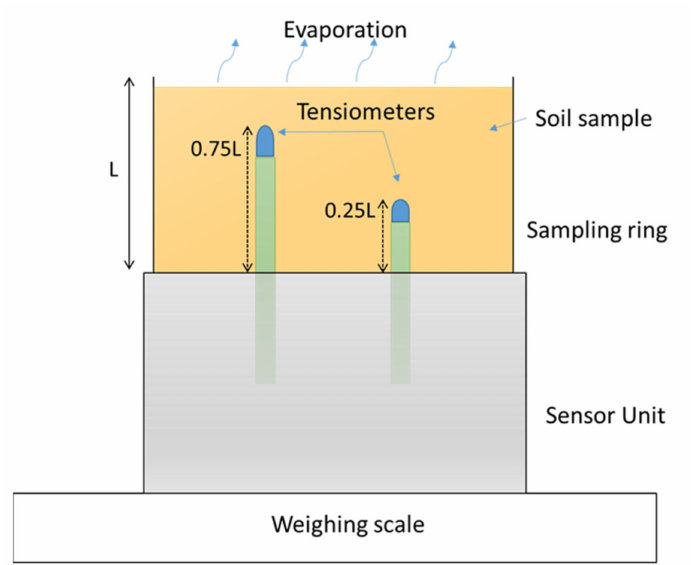
Figure 1. Experimental setup of the extended evaporation experiment using HYPROP